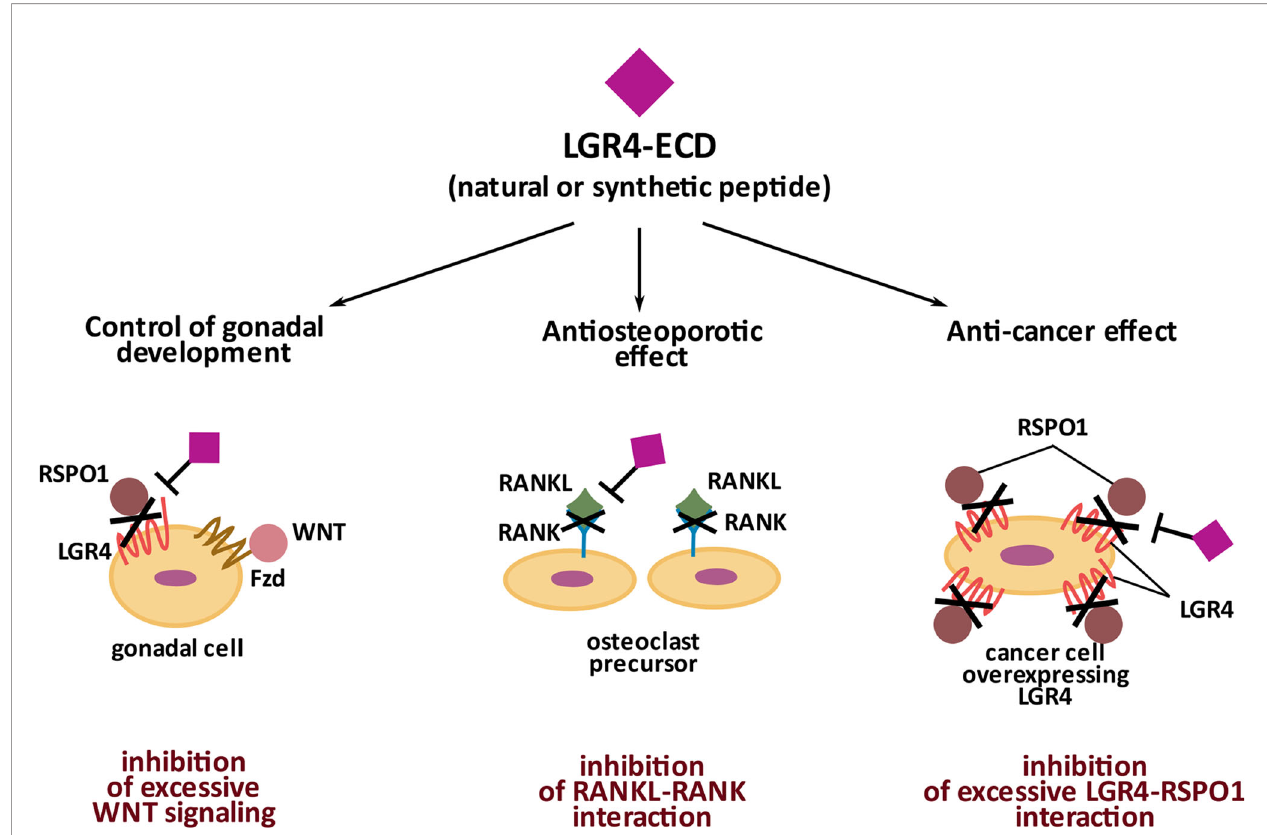
FIGURE 3 | Signi fi cance of natural and synthetic extracellular domain of LGR4 (LGR4-ECD). Naturally occurring LGR4-ECD controls gonadal development by binding RSPO1 and preventing its participation in Wnt signaling activation in gonadal cells. Synthetic LGR4-ECD by binding RANKL and preventing its interaction with RANK has an anti-osteoporotic effect. Synthetic LGR4-ECD by neutralizing RSPO1 disables its interaction with LGR4, overexpressed by cancer cells, and thus, holds an anti-cancer